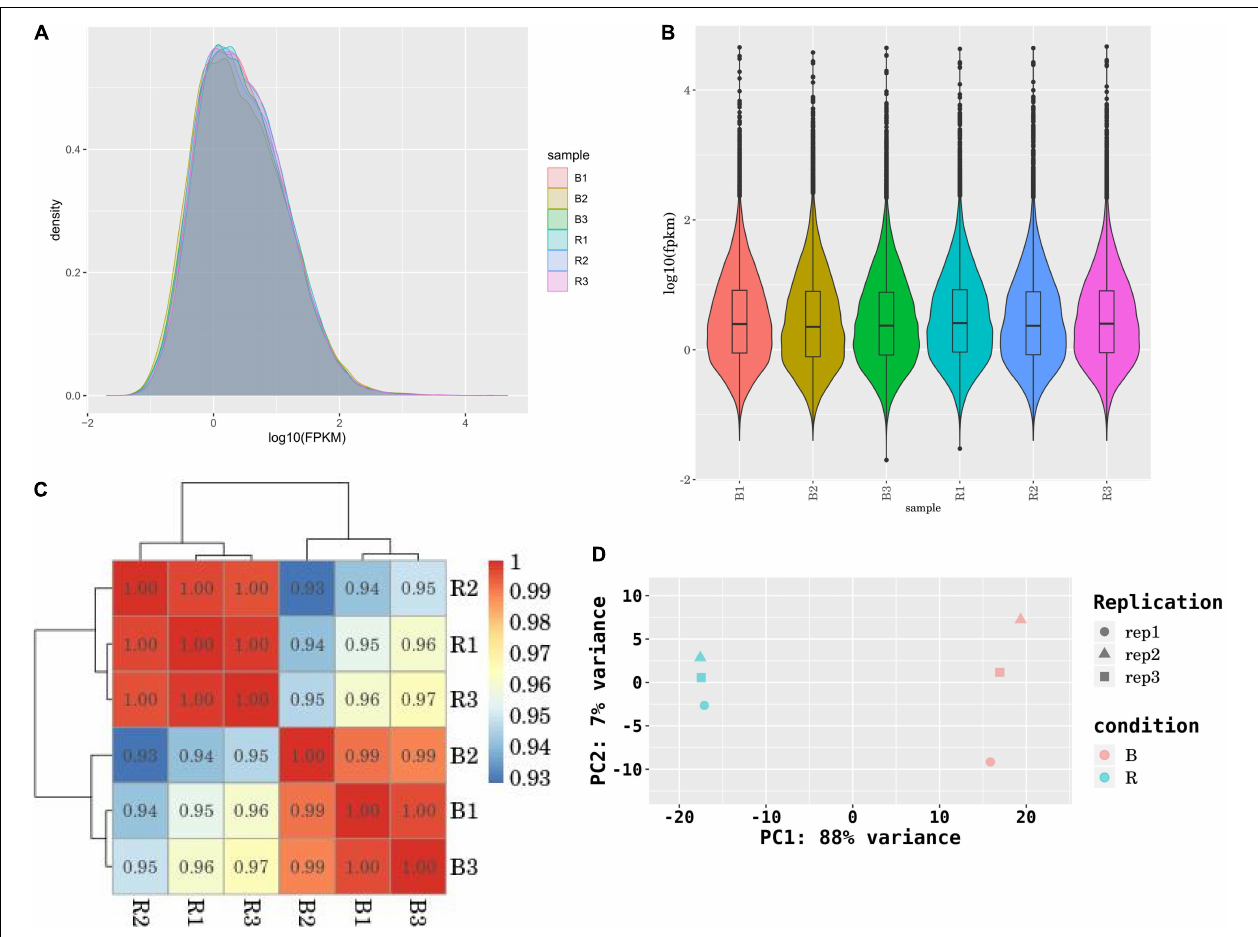
FIGURE 4 | Analysis of RNA sequencing data of six samples. (A,B) The density distribution of FPKM; (C) Correlation test of six samples; (D) PCA analysis of six